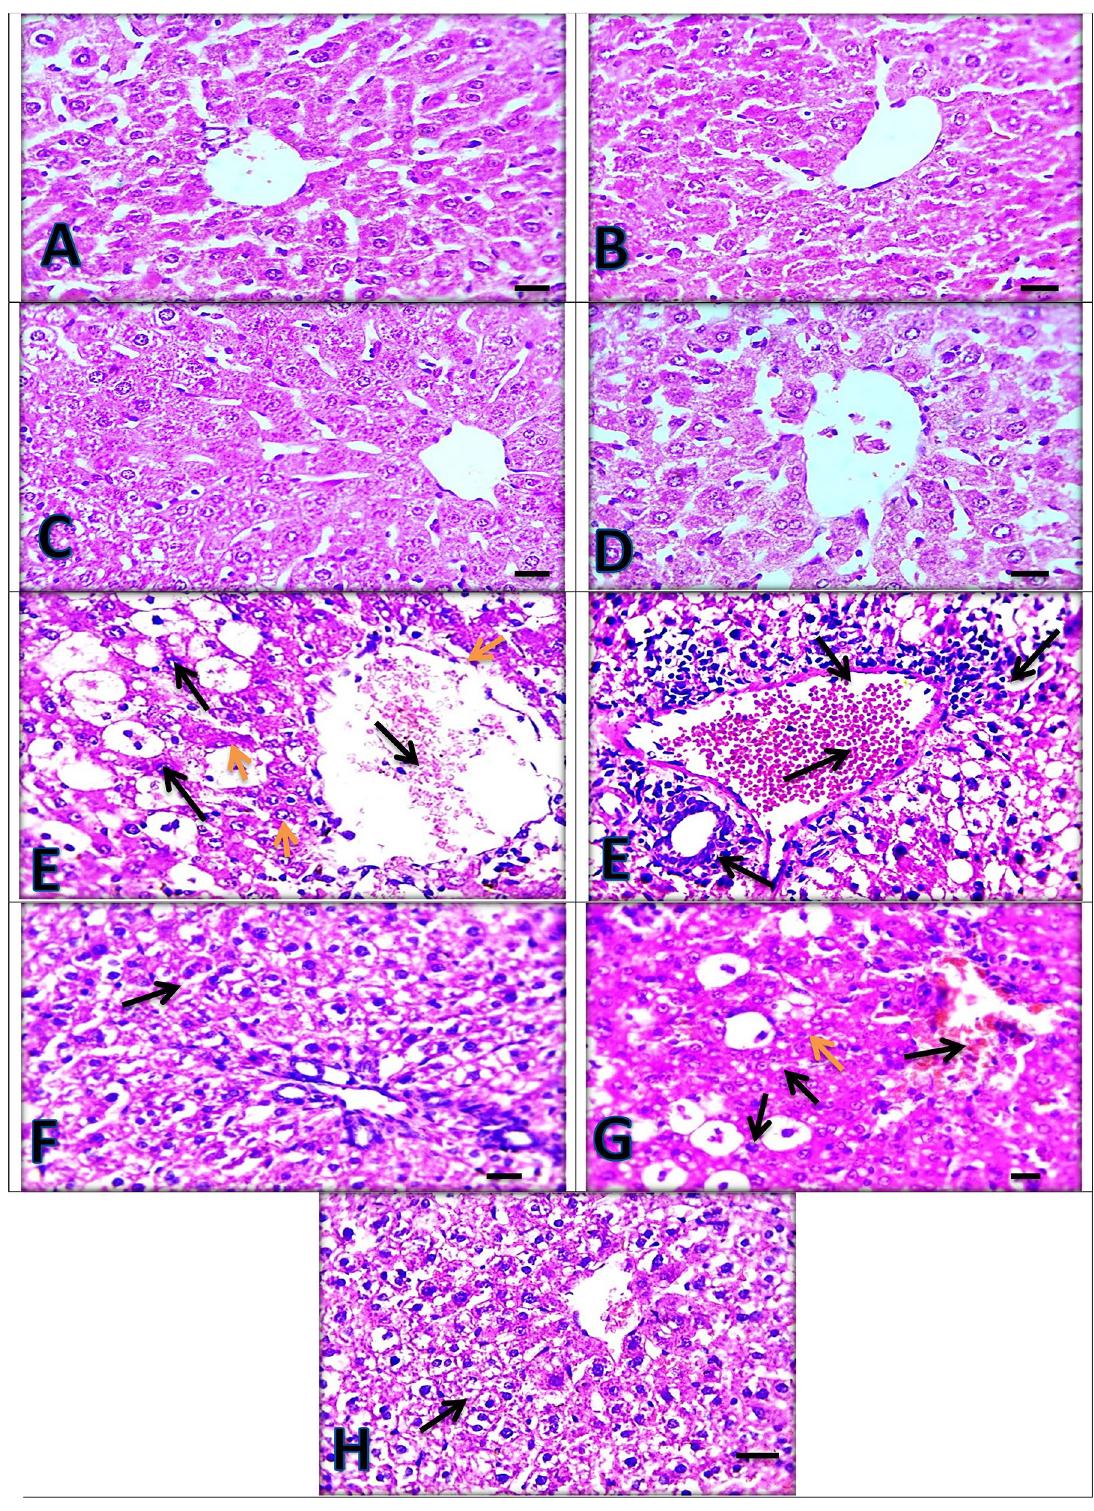
Figure 4. Liver sections showing normal appearance in ( A ) Control group, ( B ) Silymarin group, ( C ) Chlorella vulgaris group and ( D ) Chlorella vulgaris + thiamine group. ( E ) Paracetamol group showing severe congestion (black thin arrow) with marked vacuolar (yellow arrowheads) and ballooning degeneration in hepatocytes (black arrowheads) besides aggregation of lymphocytes in portal area (thick arrows). ( F ) Silymarin + Paracetamol group and ( H ) Chlorella vulgaris + Thiamine + Paracetamol group showing mild hydropic degeneration in hepatocytes (arrows). ( G ) Chlorella vulgaris + Paracetamol group showing moderate congestion (black thin arrow) vacuolar (yellow arrowheads) and ballooning degeneration (black arrowheads) in hepatocytes. ( H ) and ( E ) X: 400 bar